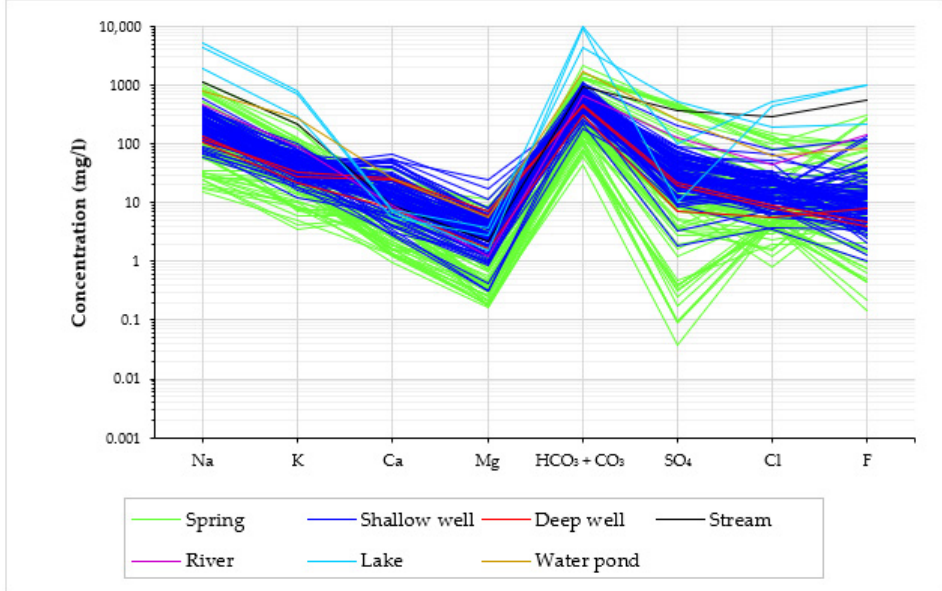
Figure 4. Schoeller diagram showing the concentrations of major ions.